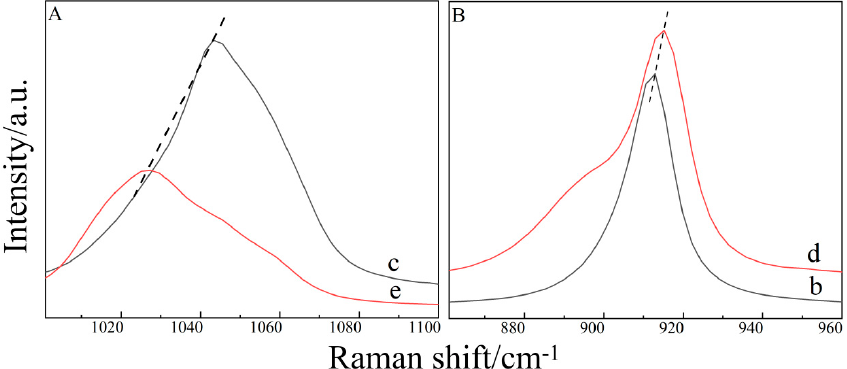
Figure 1. Raman spectra of binary aqueous solutions. ( A ) pure DMSO (Sample c) vs. H 2 O–DMSO solution (Sample e). ( B ) pure THF (Sample b) vs. H 2 O–THF solution (Sample d).